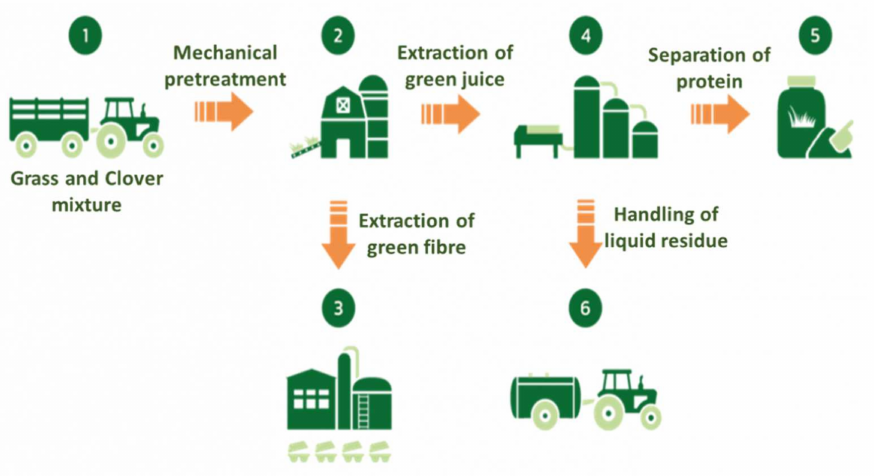
Figure 1. BioRefinery process